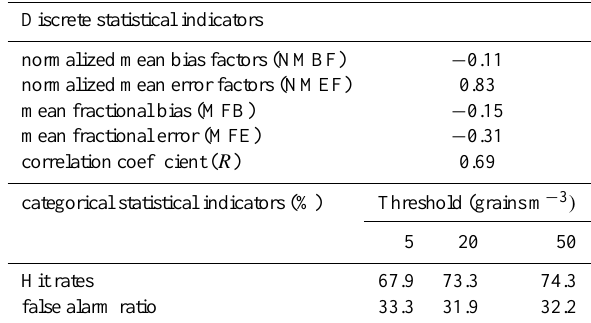
Table 3. Model performance on simulation of daily average con- centrations for 2000–2010.